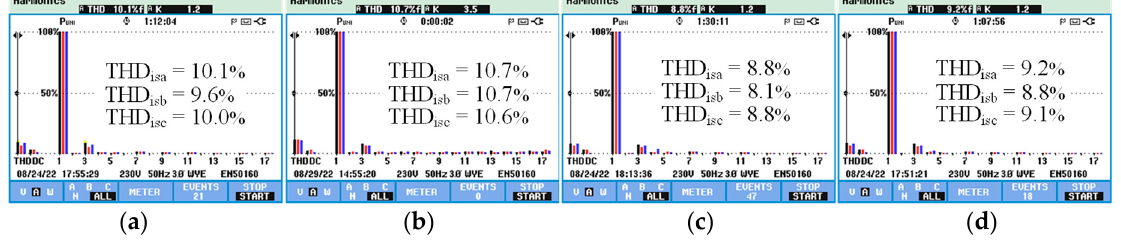
Figure 9. Experimental results of THD isx after the LC -HAPF compensation with ( a ) LQRC under 50V DC-link voltage; ( b ) LQRC under 40V DC-link voltage; ( c ) LQRIC under 50V DC-link voltage and ( d ) LQRIC under 40V DC-link voltage.